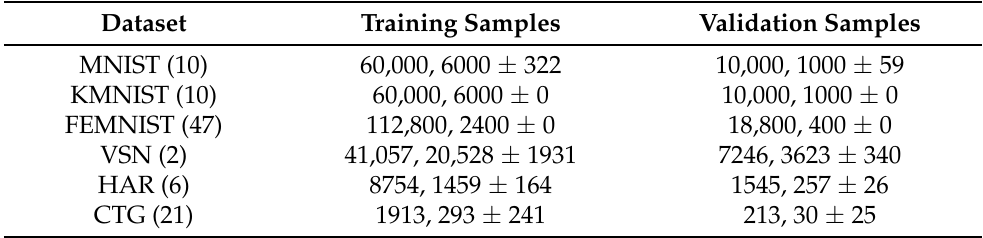
Table 1. Description of datasets used in the experiments. The numbers in parentheses in the first column indicate the number of classes. The entries in the 2nd and 3rd columns represent the total number of samples, mean number of samples per class ± standard deviation of number of samples per class.